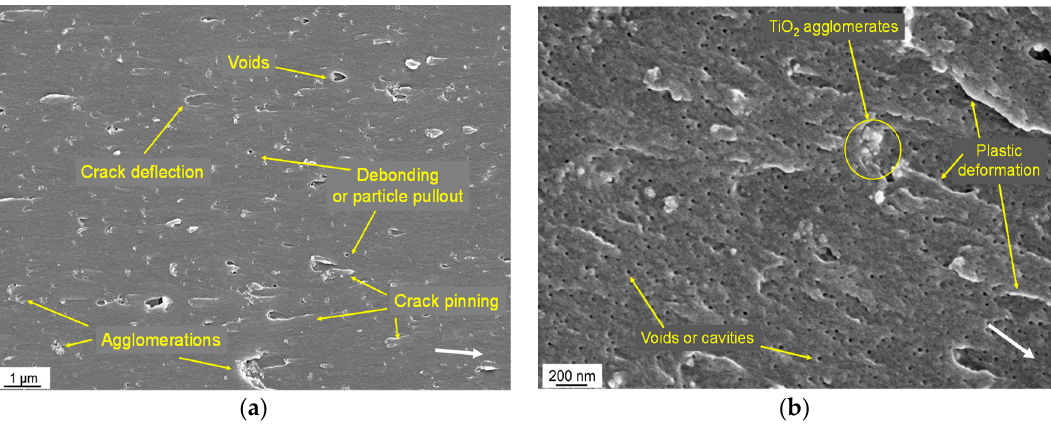
Figure 8 . SEM micrograph of the fracture surface showing the homogeneous dispersion of epoxy modified with different mechanisms for ( a ) EP_3TiO 2 and ( b ) EP_3TiO 2 _6BCP systems taken near the tip of the crack. White arrows indicate the crack propagation direction.